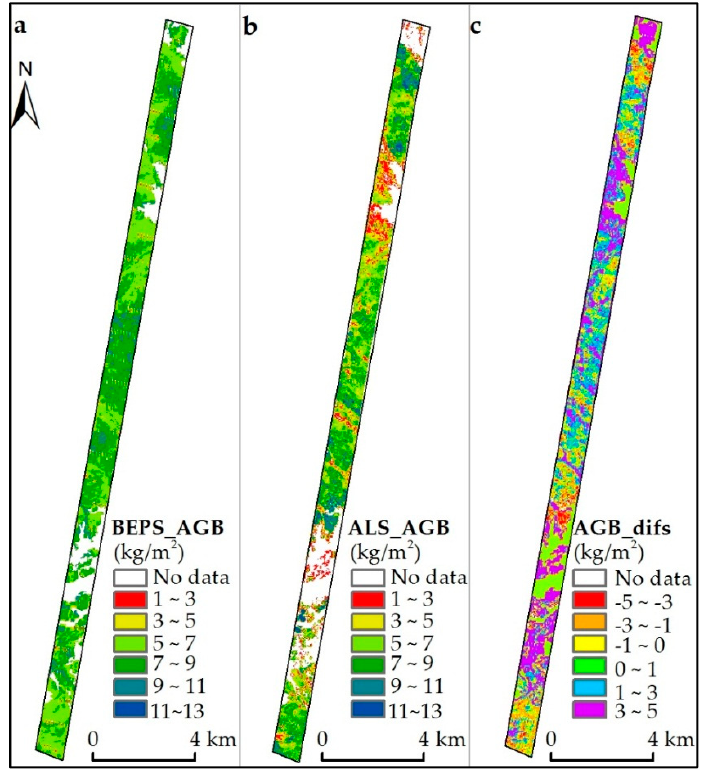
Figure 6. The spatial distribution maps of BEPS-based ( a ), ALS-based ( b ) forest AGB for 2012 and the differences map between BEPS- and ALS-based maps ( c ).